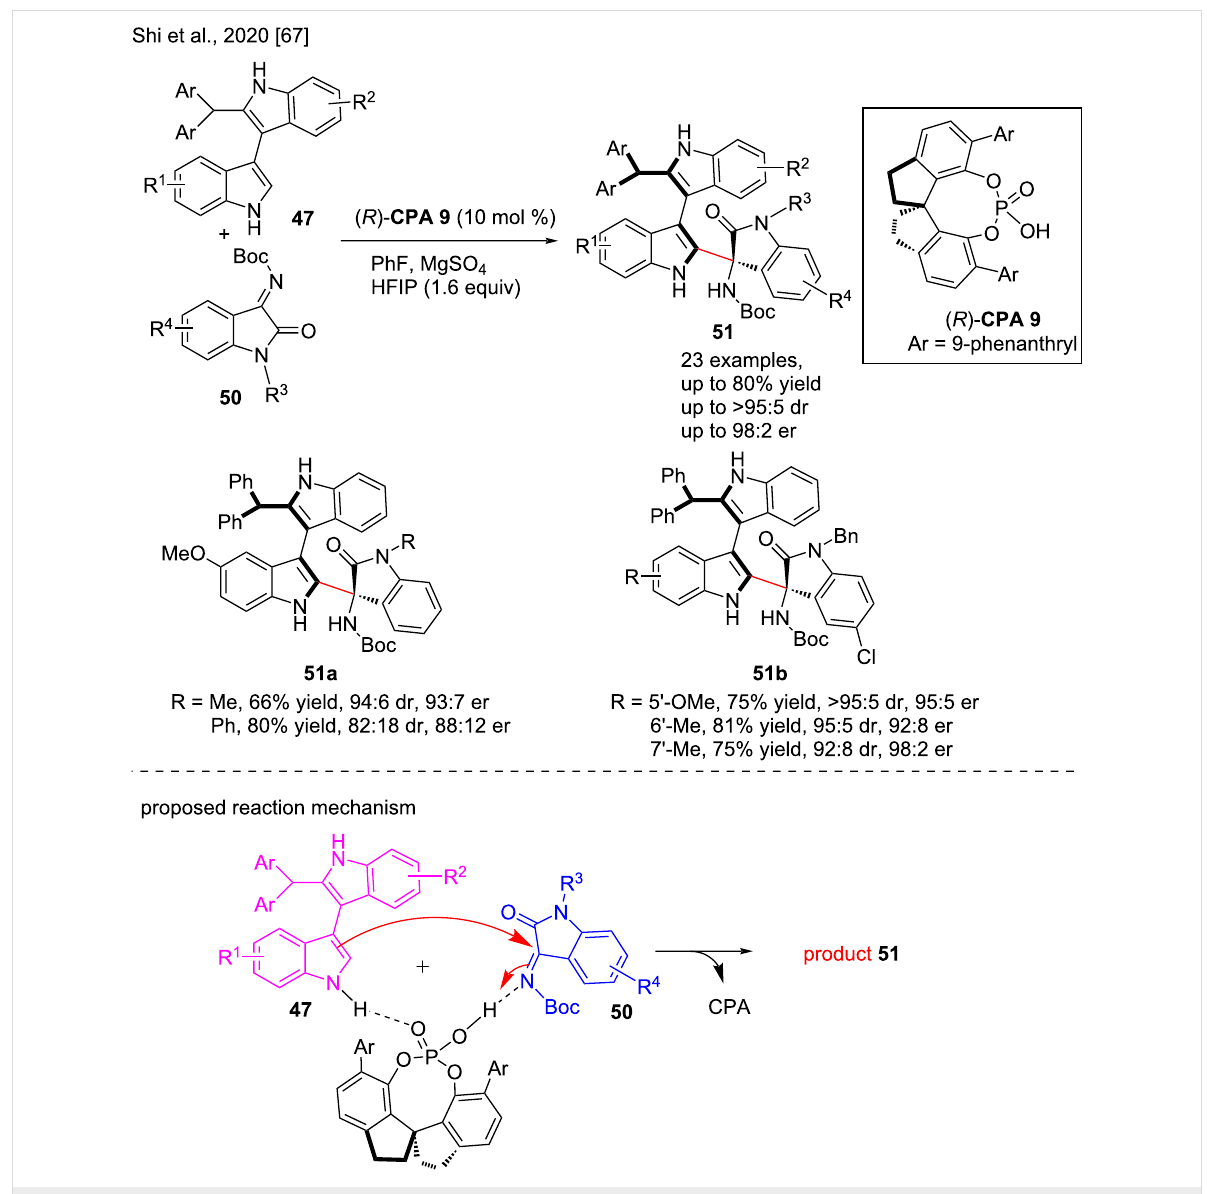
Scheme 17: Atroposelective synthesis of 3,3’-bisiindoles bearing axial and central